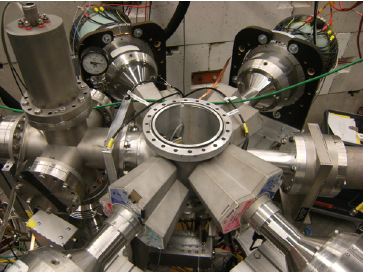
Figure 1. The experimental setup is shown. Two MINIBALL clusters were located forward and two backward with respect to the beam direction. The target chamber was positioned at the